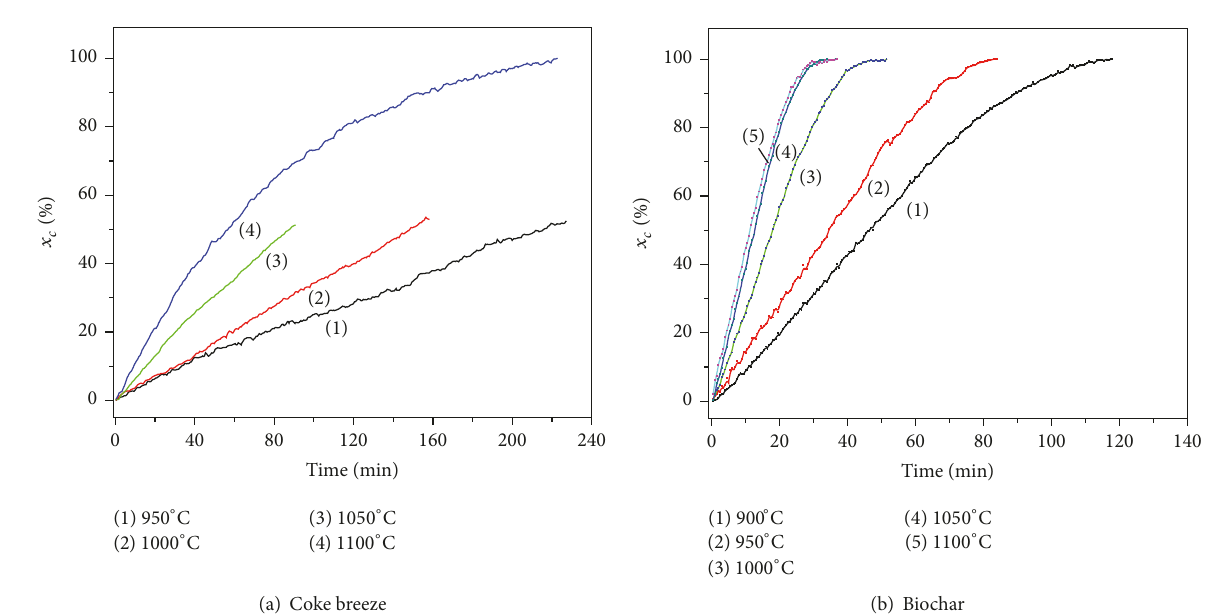
Figure 4: Effect of temperature on gasification of